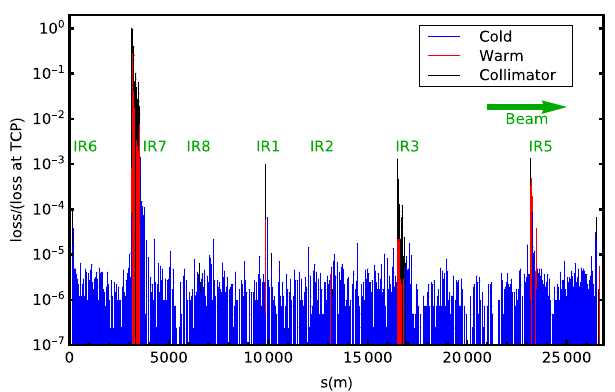
FIG. 2. Beam loss distribution around the LHC, measured with the BLMs using a 1.3 s integration time. The initial loss is provoked by a white-noise excitation of the ADT in the vertical plane of B1 at 6.5 TeV beam energy and β (cid:1) ¼ 40 cm. The TCTs were positioned at 8 . 8 σ and the rest of the collimator settings are shown in Table I. The background noise of the electronics, taken as the BLM signals without any excitation, has been subtracted. The color indicates if the monitor is attached to a cold machine element (blue), a warm machine element (red), or a collimator